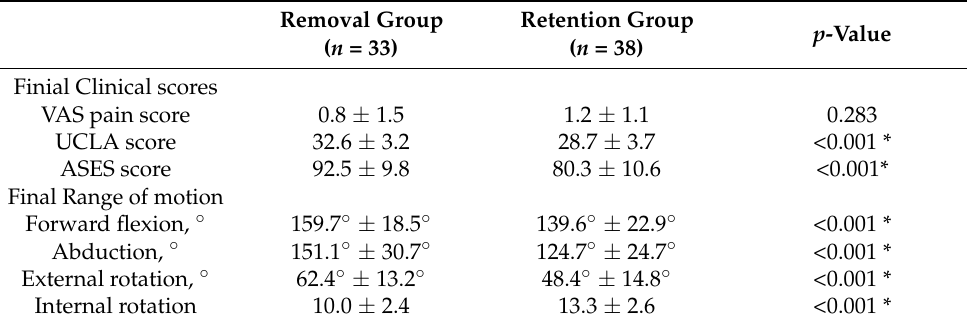
Table 2. Comparison of clinical outcomes between device removal and retention